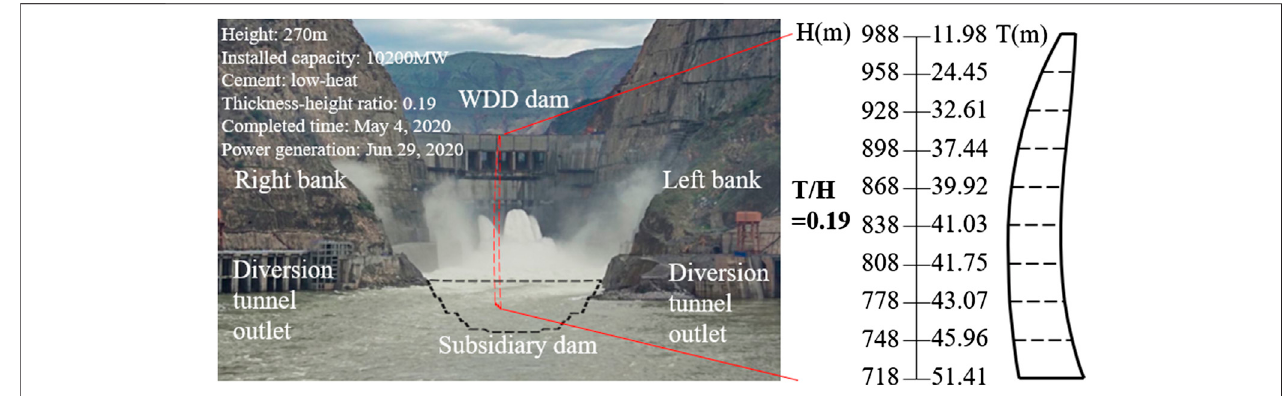
FIGURE 6 | General view of the super-high arch